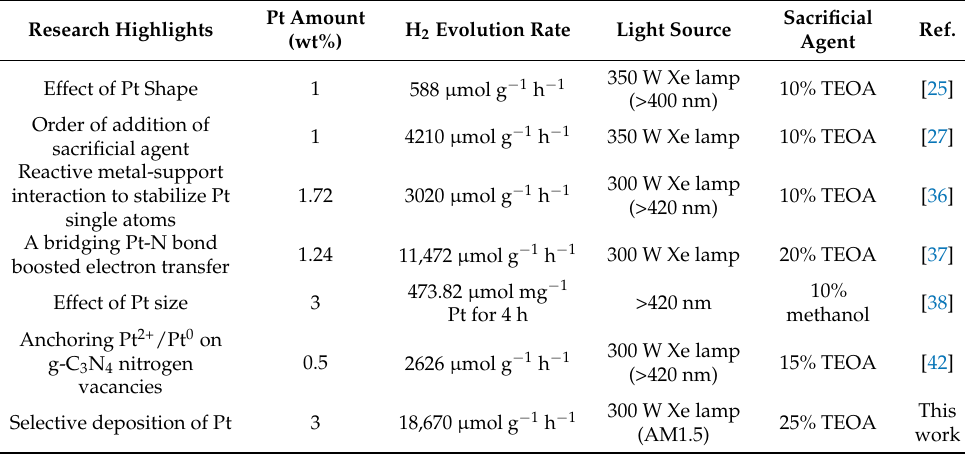
Table 1. The main concerns and hydrogen evolution data of previous